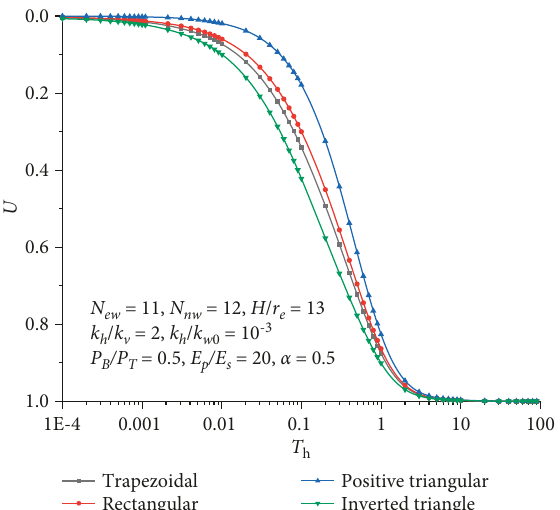
Figure 5: Influence of α on average consolidation degree when radial-vertical flow is considered.